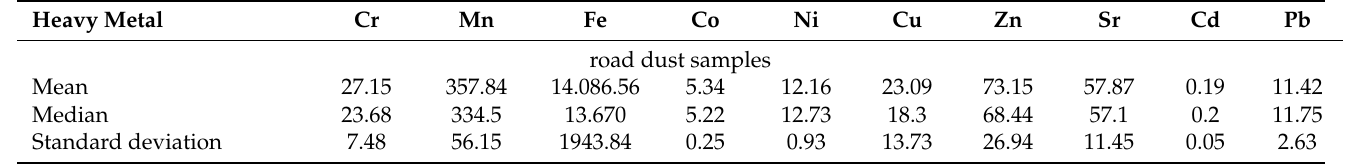
Table 1. Statistical Indicators of Metal Content in road dust samples and Background Soils (mg kg − 1